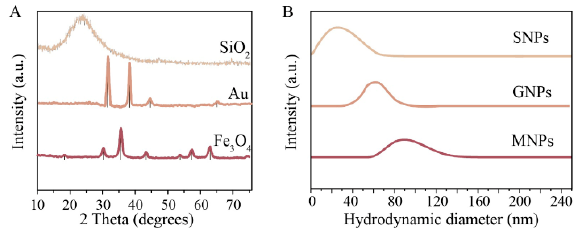
Figure 2. ( A ) XRD patterns of SNPs (top), GNPs (middle), and MNPs (bottom). Black vertical lines are showing reference to JCPDS file No. 19-0629 and JCPDS file No. 2-1095. ( B ) hydrodynamic diameter distribution of SNPs (top), GNPs-30 (middle), and MNPs (bottom). MNPs and GNPs both have positively charged surfaces, while SNPs were negatively Table 1. Hydrodynamic size, ζ -potential of NPs, and their ratios.